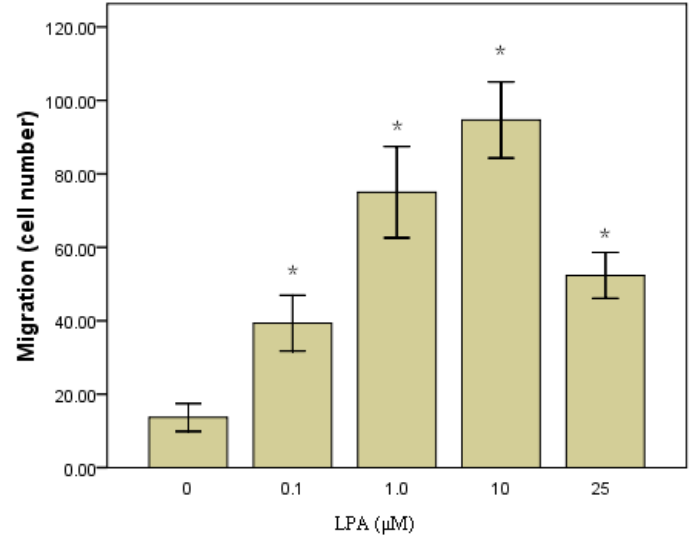
Figure 1. LPA-induced migration of